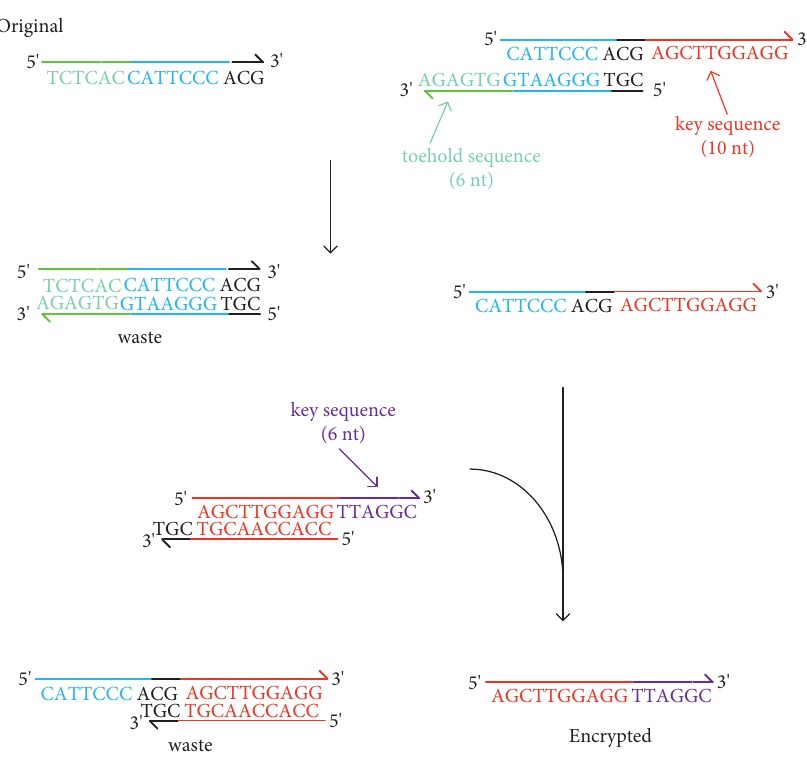
Figure 7: The DNA sequence encryption principle of DSD-rule c.